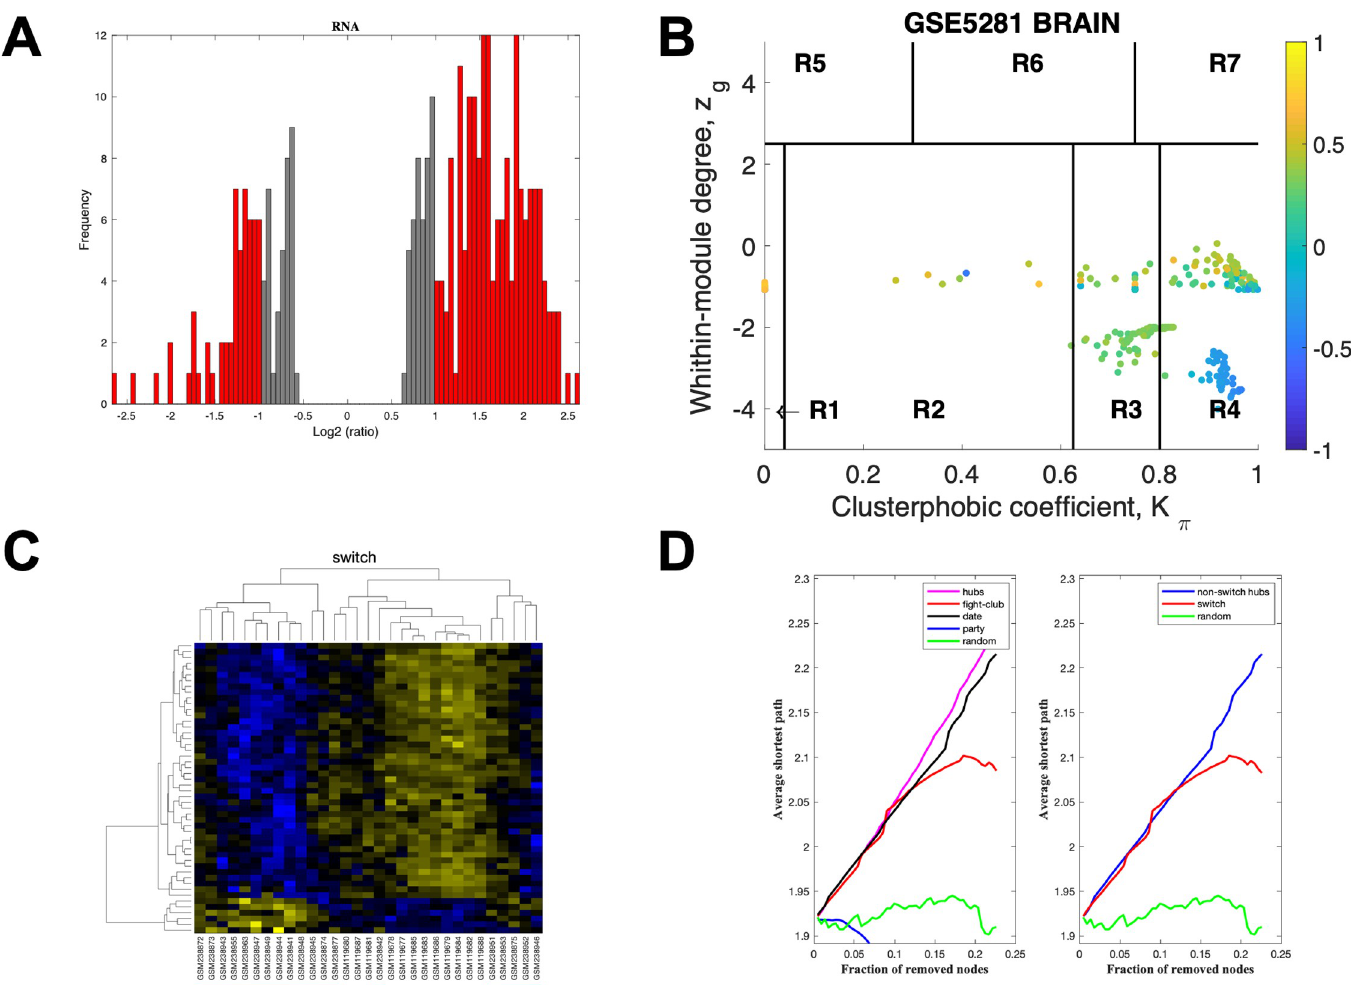
Fig 8. SWIM analysis of the primary visual cortex. A. Distribution of the fold-change values for GSE5281 brain microarray gene expression data from the VCX. The x- axis represents the fold-change value (log2 of the fold-change) that is the ratio of the average expression data in AD patients compared to the average expression data in normal controls computed for protein-coding and non-coding RNAs. The y-axis represents the frequency of the obtained fold-change values. The grey bars represent the fold-change values associated with protein-coding and non-coding RNAs that will be discarded according to the selected threshold. The red bars represent the fold-change values associated with protein-coding and non-coding RNAs that were retained for further analysis. B. Heat cartography map for GSE5281 brain data from the VCX. correlation network. The plane is identified by two parameters: Zg (within-module degree) and Kπ (clusterphobic coefficient) and it is divided into seven regions each defining a specific node role (R1-R7). High Zg values correspond to nodes that are hubs within their module (local hubs), whereas low Zg values correspond to nodes with few connections within their module (non-hubs within their communities, but they could be hubs in the network). Each node is colored according to its average Pearson Correlation coefficient (APCC) value. Yellow nodes are party and date hubs, which are positively correlated in expression with their interaction partners. Blue nodes are the fight-club hubs, which have an average negative correlation in expression with their interaction partners. Blue nodes falling in the region R4 are the switch genes, which are characterized by low Zg and by high Kπ values and are connected mainly outside their module. C. Dendrogram and heat map for switch genes in GSE5281 brain microarray gene expression data from the VCX. The expression profiles of switch genes (including protein-coding and non-coding RNAs) are clustered according to rows (switch genes) and columns (samples) of the switch genes expression data (biclustering). The colors represent different expression levels that increase from blue to yellow. The red line under the x axis labels denotes AD samples. D. Robustness for the GSE5281 brain correlation network from the VCX. The x-axis represents the cumulative fraction of removed nodes, while the y-axis represents the average shortest path. The shortest path between two nodes is the minimum number of consecutive edges connecting them. Each curve corresponds to the variation of the average shortest path of the correlation network as function of the removal of nodes specified by the colors of each